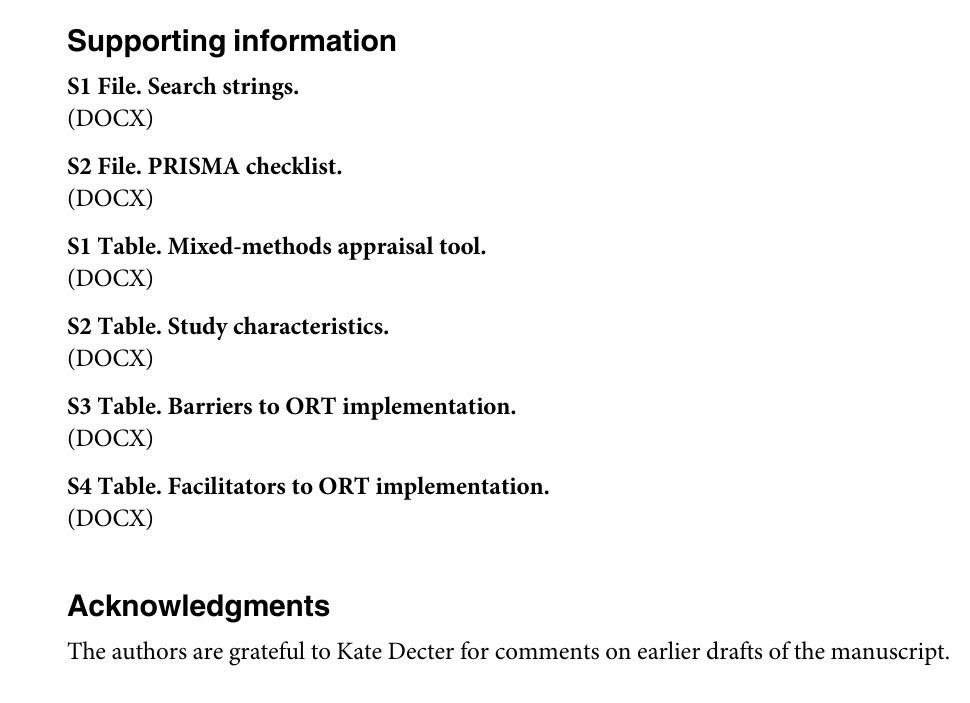
S1 Table. Mixed-methods appraisal tool. S2 Table. Study characteristics. S3 Table. Barriers to ORT implementation. S4 Table. Facilitators to ORT